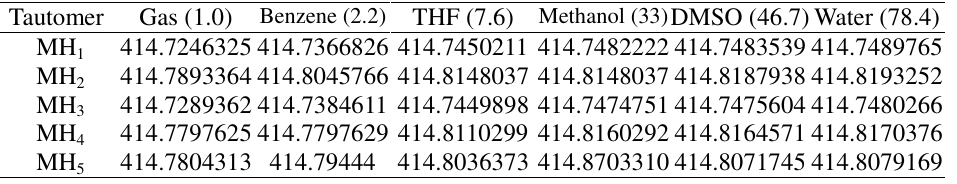
Table 1. Total energies at B3LYP/6-31++G ** and relative stability in the gas phase and